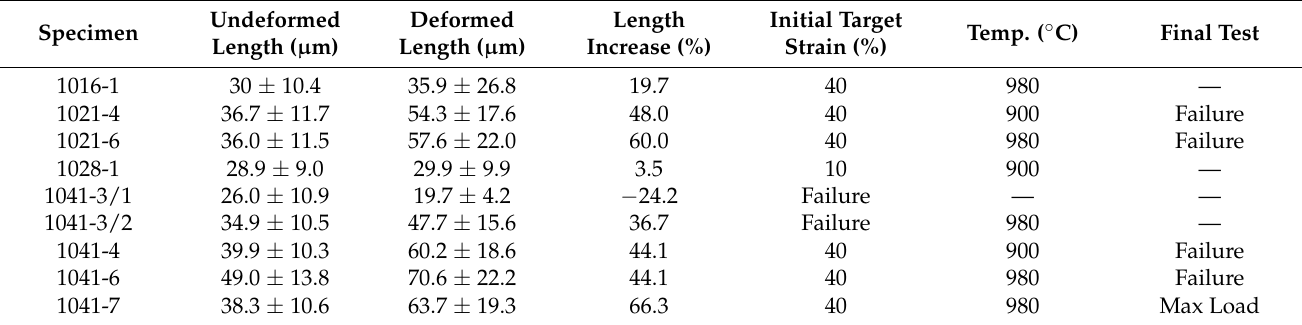
treatment cycles. Table 5 lists the grain length for undeformed and deformed specimens measured through optical microscopy.